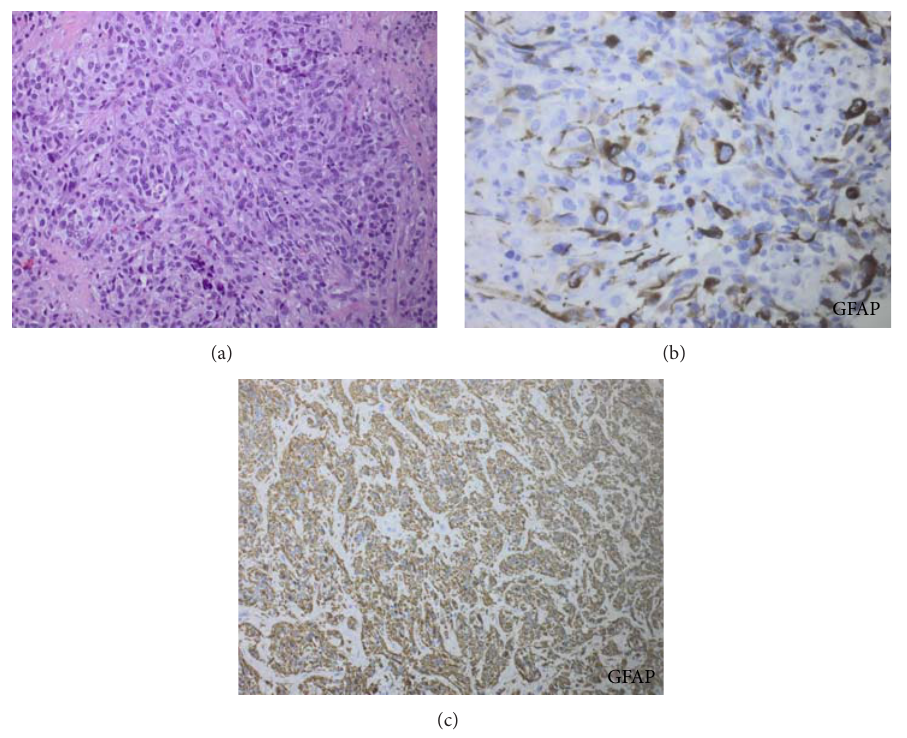
Figure 2: Histopathology from both cases. (a) HE staining ( × 20) of cervical lymph node metastasis from case 1. (b) GFAP staining ( × 40) of cervical lymph node metastasis from case 1. (c) GFAP staining ( × 10) of liver metastasis from case